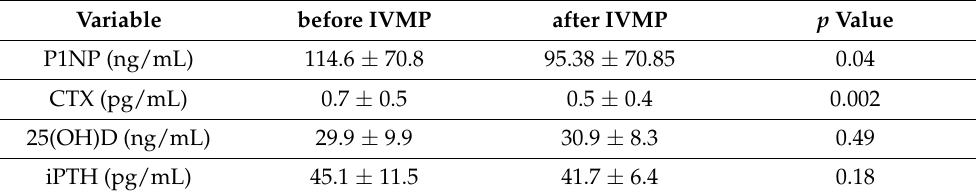
Figure 4. Effect of IVMP therapy (12 weeks with once-weekly intravenous pulses with a cumulative dose of 4.5 g) on P1NP and CTX. * p value < 0.05 vs. before IVMP therapy; ** p value < 0.01 vs. before IVMP therapy; CTX, C-terminal telopeptide of type I collagen; IVMP, intravenous methylprednisolone; P1NP, amino-terminal propeptide of type I procollagen. Table 2. Parameters of bone turnover before and after 12 IVMP pulses given in a weekly schedule with a cumulative dose of 4.5 g in 16 patients with Graves’ orbitopathy .